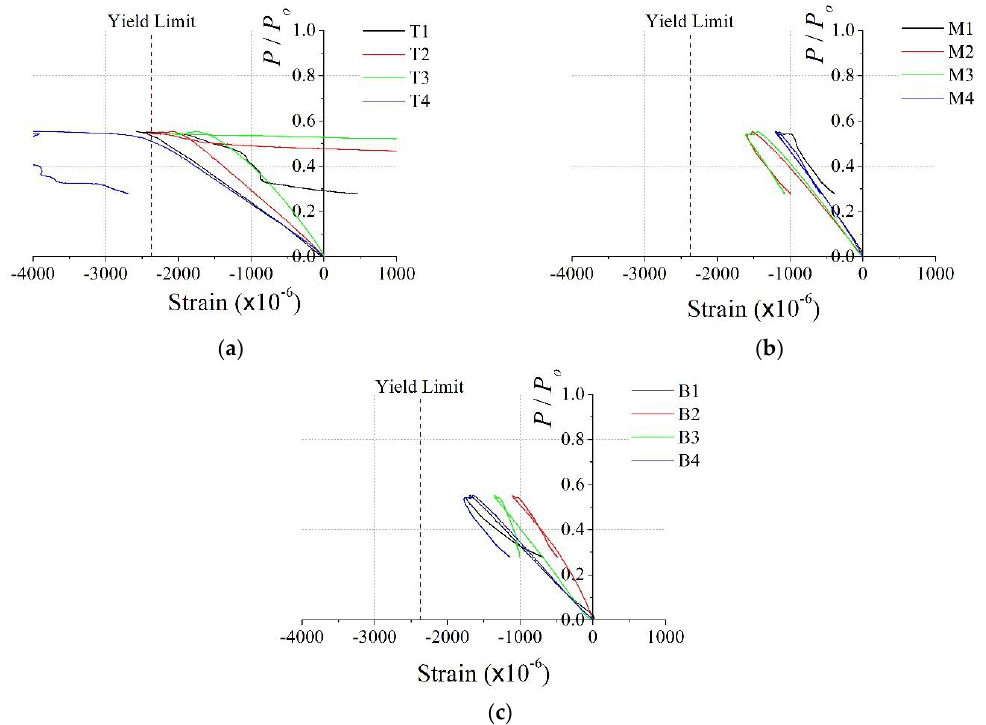
Figure 10. Dimensionless axial load vs. vertical stain for PAL25: ( a ) top (T1–4); ( b ) middle (M1–4); ( c ) bottom